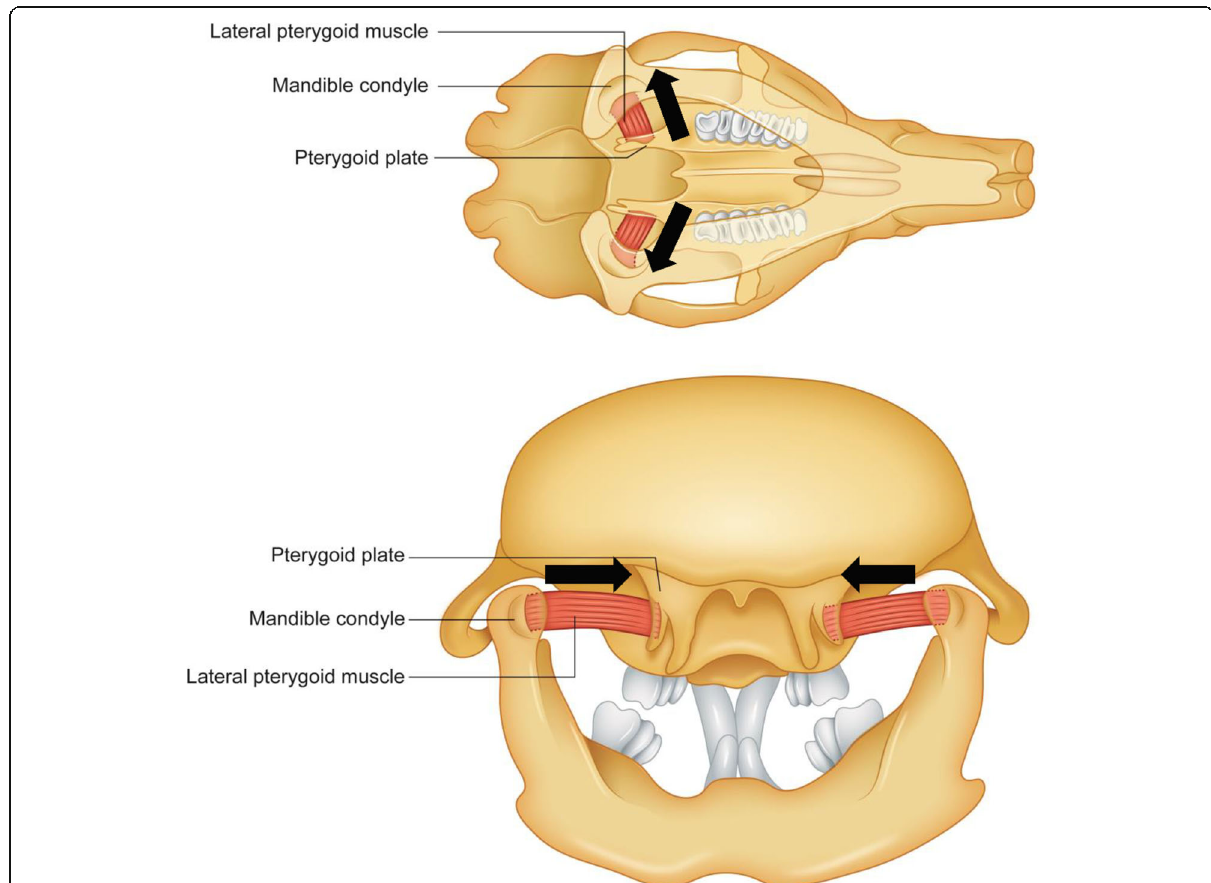
Fig. 4 The schematic illustration of the effect of the lateral pterygoid muscle hyperactivity to the growth of the mandibular condyle and maxillary width. The hyperactivity of the lateral pterygoid muscle generates the tensional force to the mandibular condyle and pterygoid plate (black arrow). It contributes to the decrease of the bi-condylar width and increase of the maxillary width according to the posterolateral direction of the